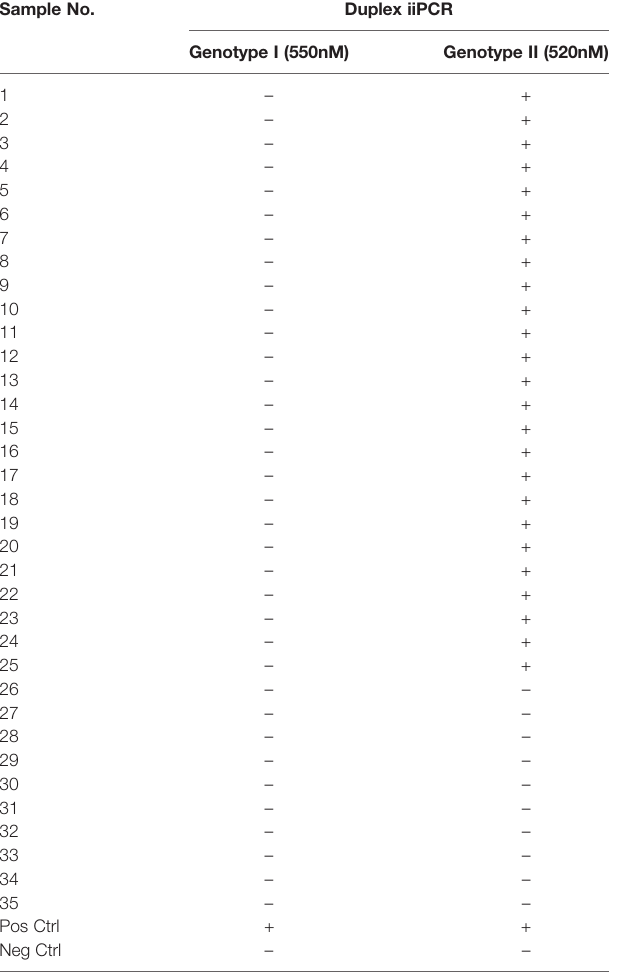
TABLE 6 | Sensitivity comparison of the duplex iiPCR using unextracted or extracted ASFV genotype II positive serum sample. Dilution Unextracted ASFV positive serum Extracted DNA